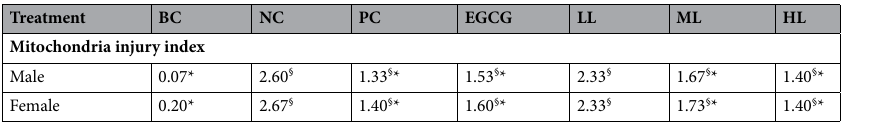
Table 3. Mitochondria damage index of various treatments. *Being significantly different from BC at p < 0.05. § Being significantly different from NC at p < 0.05.